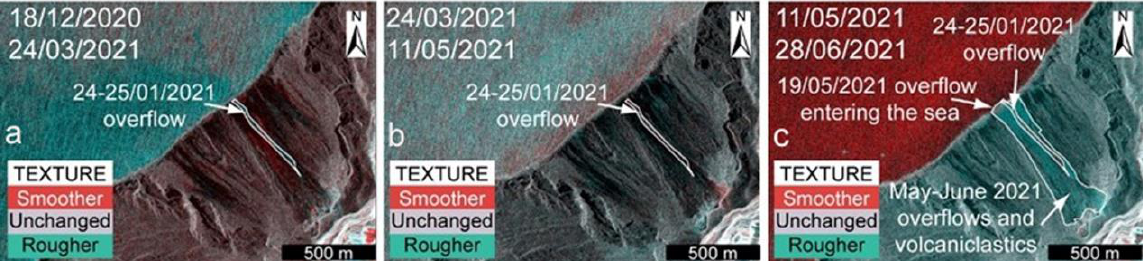
Figure 7. RGB colour composite of amplitude CSK images: ( a ) 24 March 2021 – 18 December 2020; ( b ) 25 May 2021 – 24 March 2021; ( c ) 28 June 2021 – 25 May 2021.